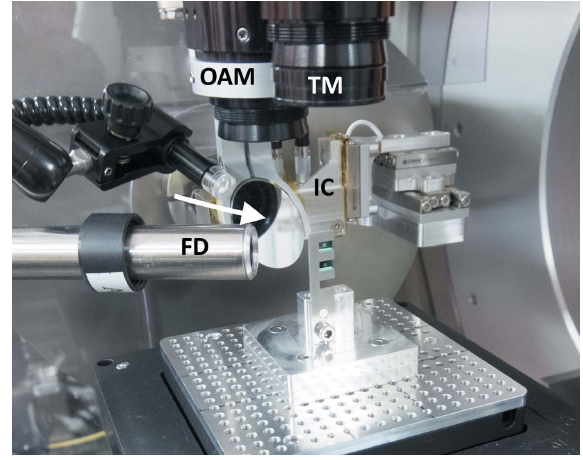
Figure 11 A close-up photograph of the sample stage: the top microscope (TM), the on-axis microscope (OAM), the 45 (cid:3) mirror with the central hole indicated by the white arrow, the ion chamber (IC) and the fluorescence detector (FD) are marked. The comb-like sample support is designed for X-ray fluorescence and/or transmission measurements. The breadboard fixed on the sample scanner provides flexibility for sample